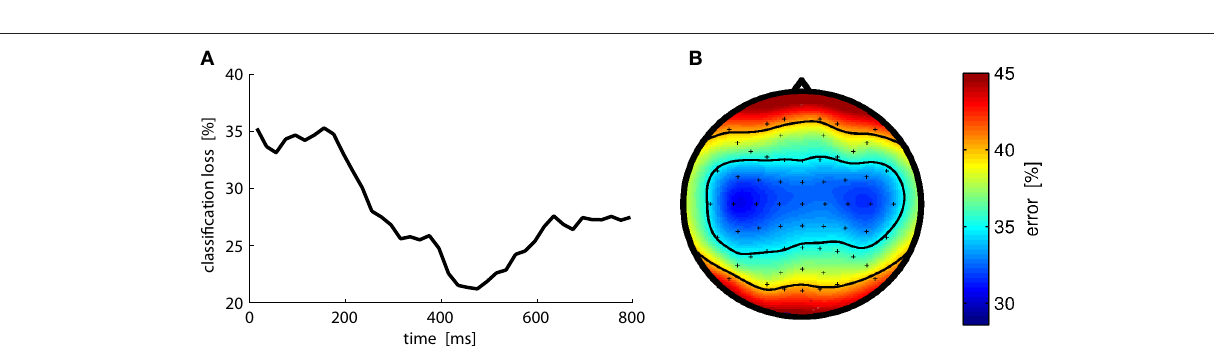
FIguRE 6 | grand average temporal (A) and spatial (B) distribution of discriminative information. Reported loss values in the temporal domain are obtained for a sliding window of 50 ms. The loss values obtained for each electrode separately are depicted as a scalp topography (B) .